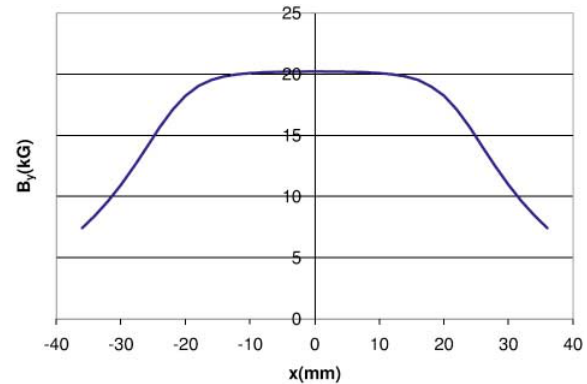
FIG. 1. (Color) Transverse field roll-off in BL11 wiggler.